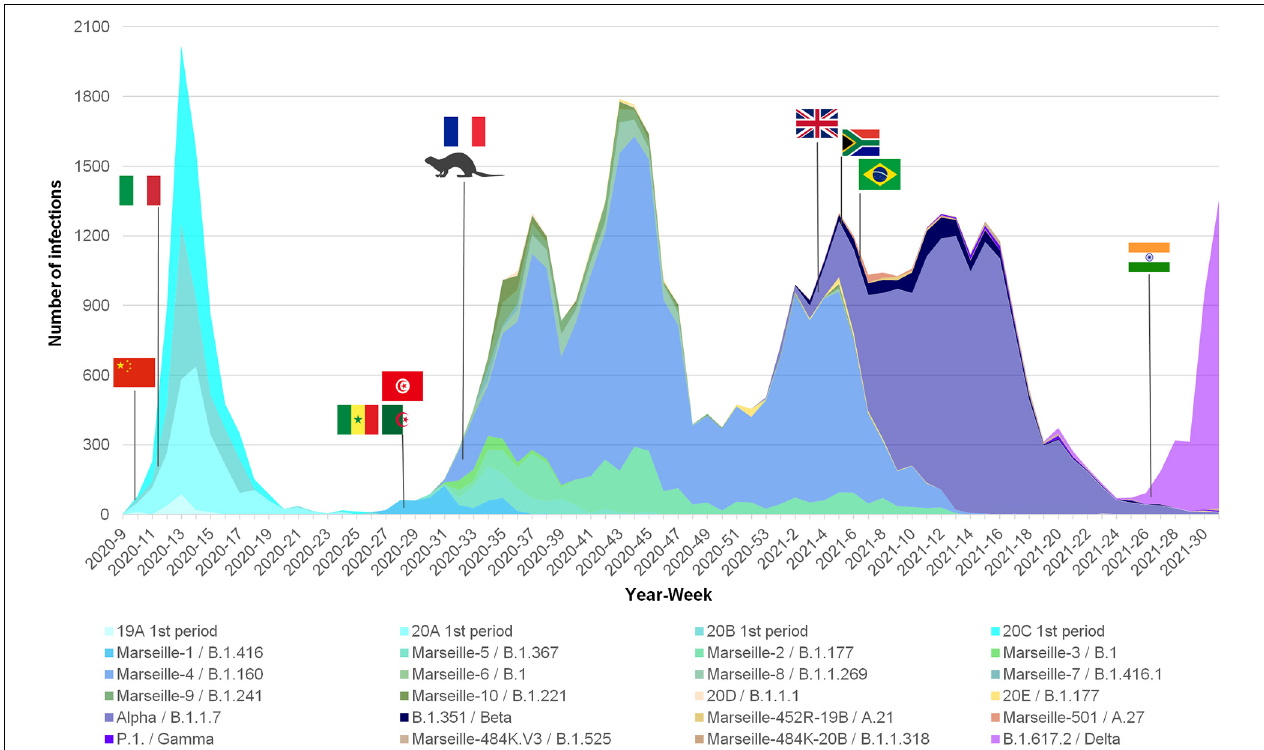
FIGURE 6 | Weekly incidence of each SARS-CoV-2 mutants and variants extrapolated to the total number of cases, based on their proportions of genotyped cases, among patients SARS-CoV-2-diagnosed at IHU Méditerranée Infection institute.